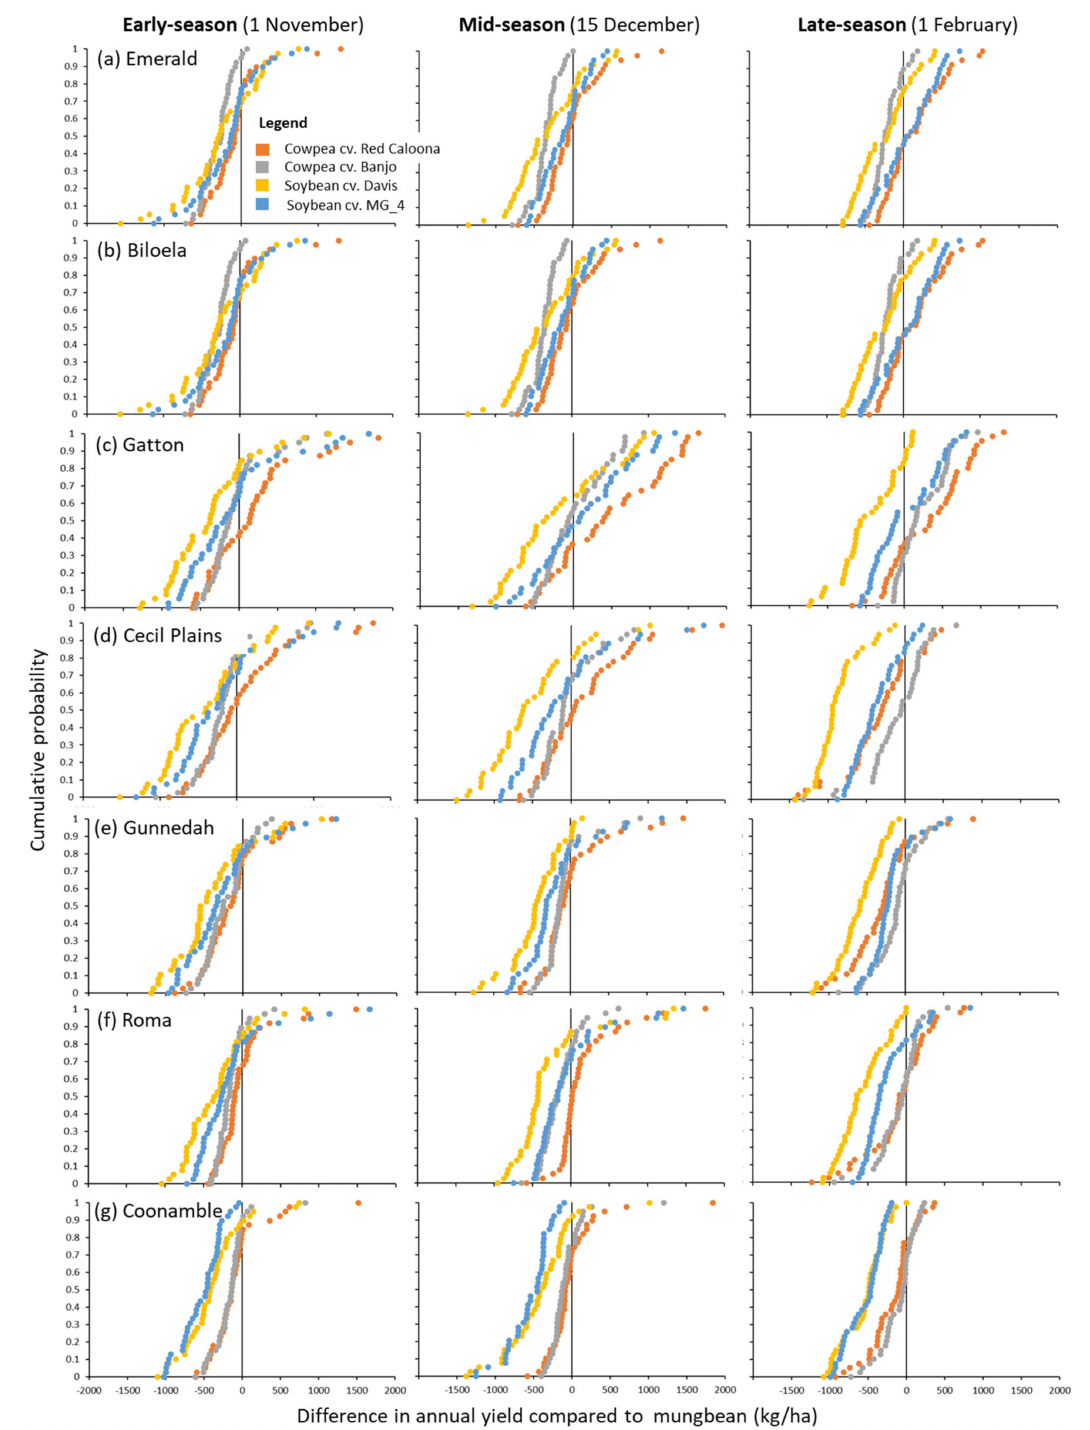
Figure 3. Difference in APSIM-predicted annual yields of cowpea and soybeans genotypes compared to those of mungbean (cv. Emerald) over 40 simulated years at different sowing dates (early: 1 Nov, mid: 15 December or late: 1 February) across 7 locations spanning Australia’s subtropical grain-producing environments. See Table 1 for details of climate and soils at each